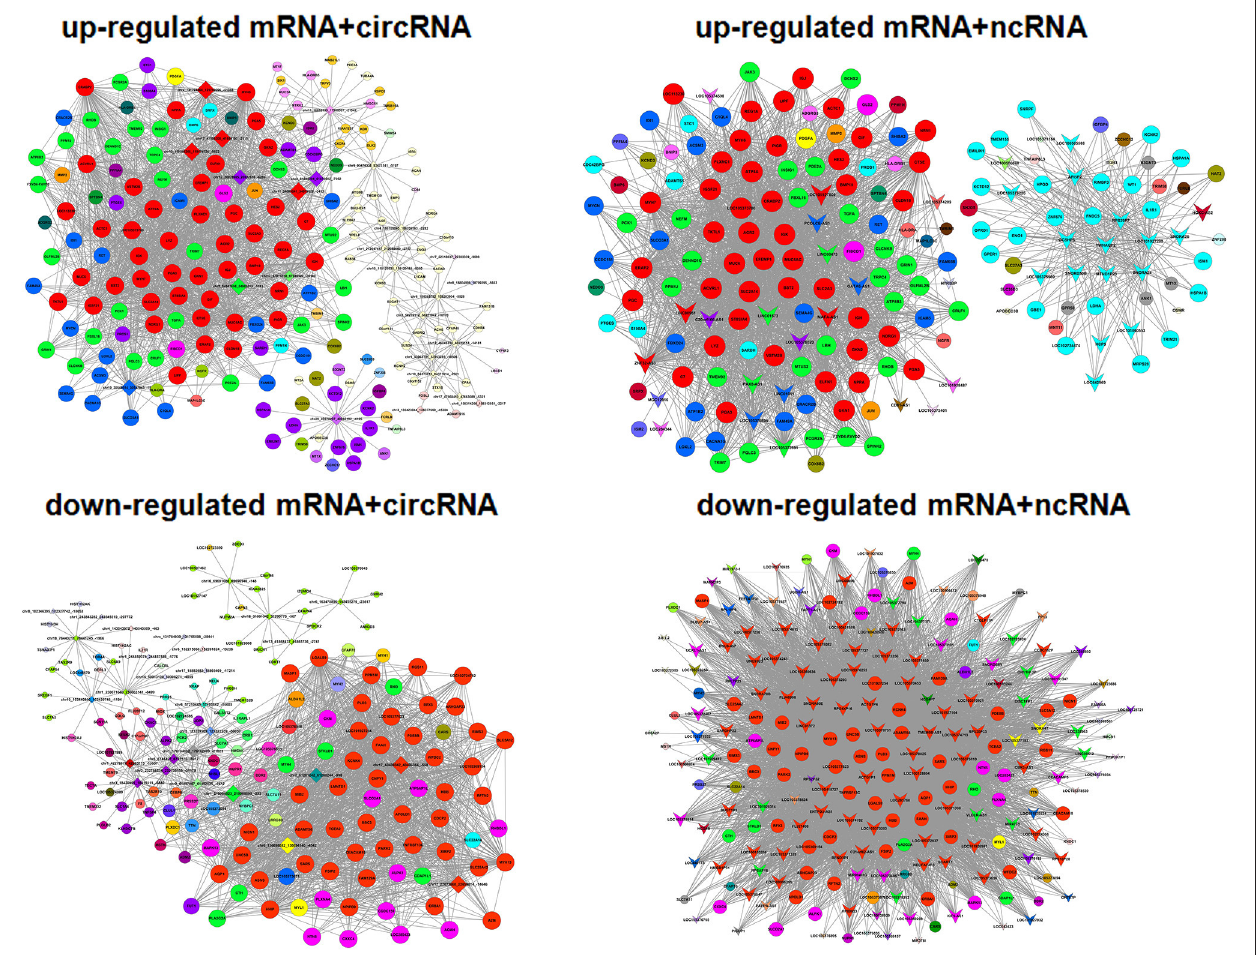
FIGURE 5 | Gene co-expression networks. Up-regulated and down-regulated RNAs were selected to construct co-expression networks by calculating the Pearson correlation for each pair of RNAs. A round node represents a protein-coding gene, a triangular node represents a ncRNA, and a diamond node represents a circRNA. Red nodes represent the key regulatory genes with the highest k-core values. Node colors indicate k-core values. Node size represents the k-core power, and the distance between two nodes represents the interaction between the two RNAs.